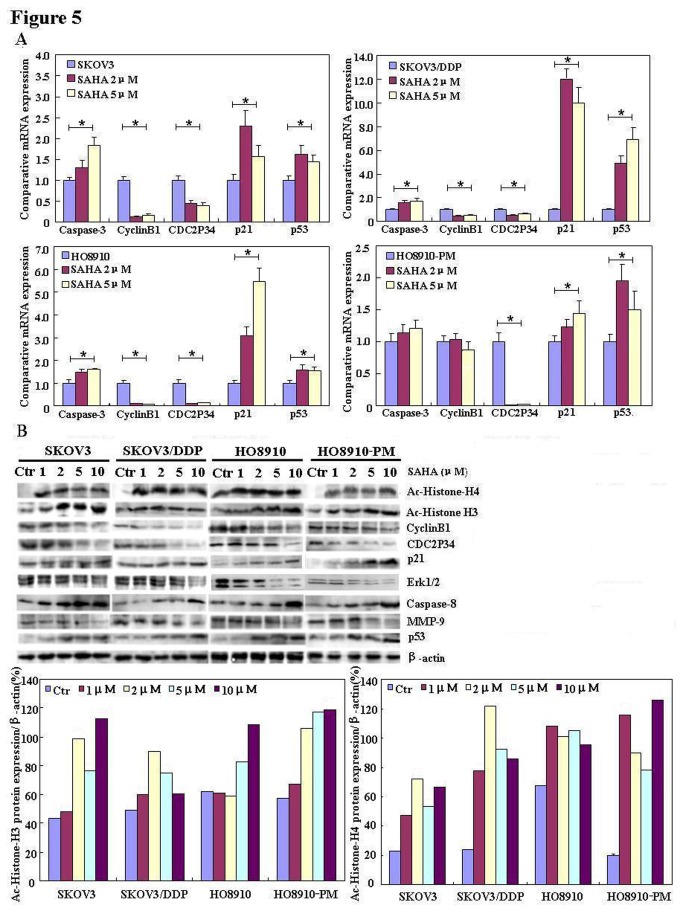
The mRNA and protein expression profiles of ovarian carcinoma cells treated with SAHA.Effects of SAHA exposure on the mRNA expression levels of phenotype-related molecules, and their corresponding proteins, in the ovarian carcinoma cell-line pairs: (A,n=3) real-time RT-PCR and (B) Western blot analysis. * P < 0.05.